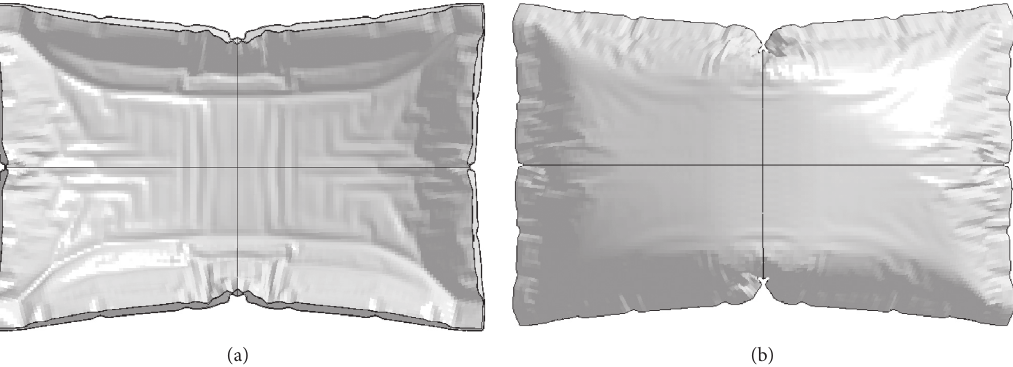
Figure 27: Deformation of ST3 in numerical simulation. (a) Explosion-facing panel in numerical simulation. (b) Explosion-back panel in numerical